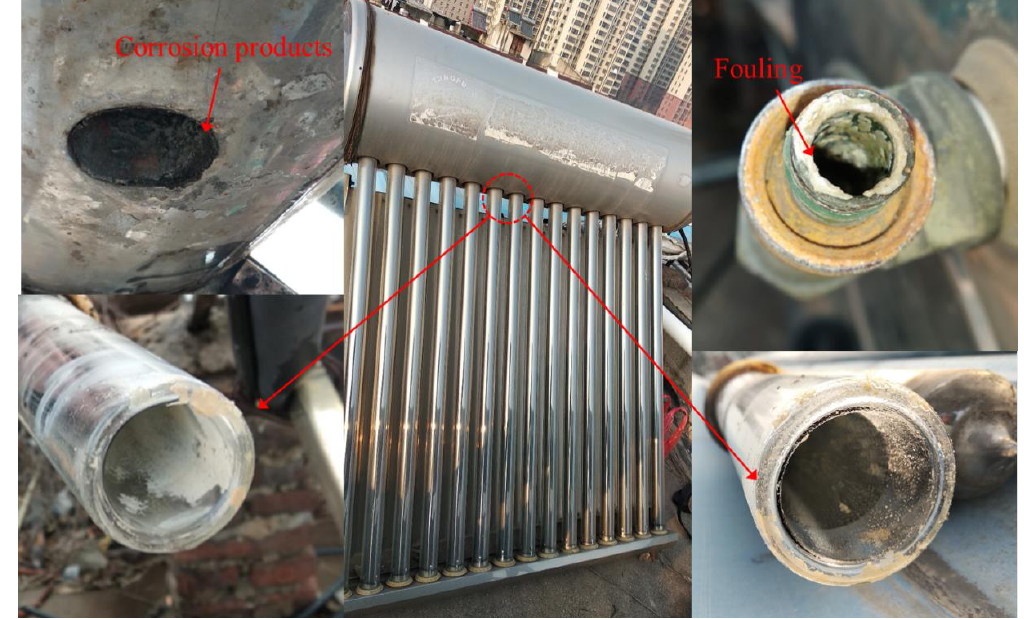
Figure 1. Fouling on the pipes of solar collectors after long periods of use.